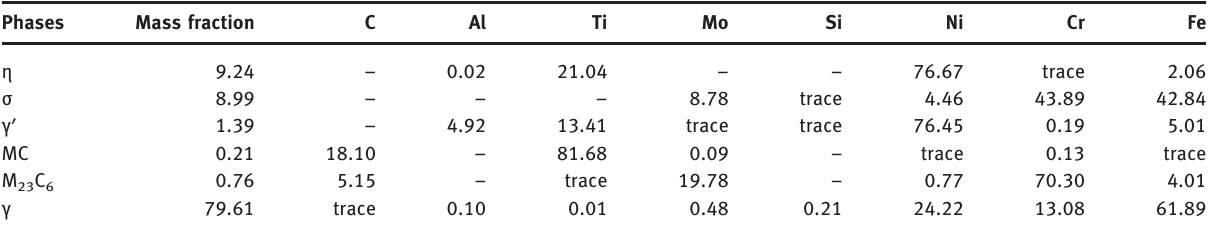
Table 2: Calculated compositions of equilibrium phases at 550°C.